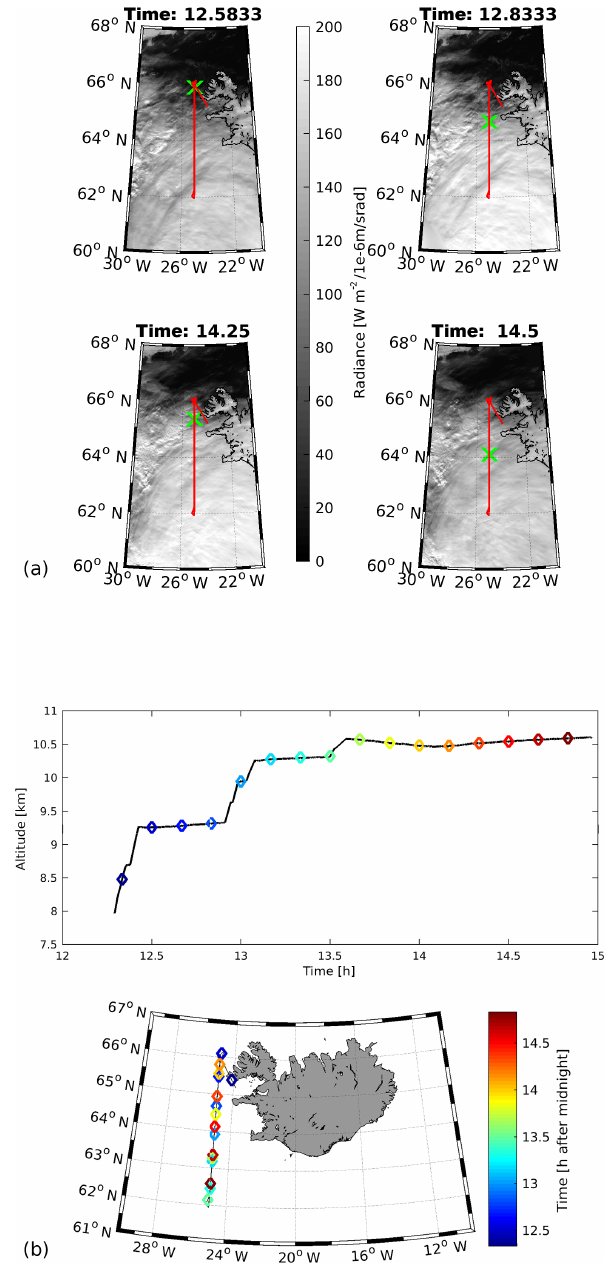
Figure 6. (a) Images of MODIS (Terra and Aqua) band 1 (visi- ble) during flight B897 on 18 March 2015 overlaid with the flight track (red lines) and the position of the aircraft (green crosses) at the MODIS measurement time. (b) Altitude time series of flight B897 and below map with the flight track (black) with a color marker indicating the